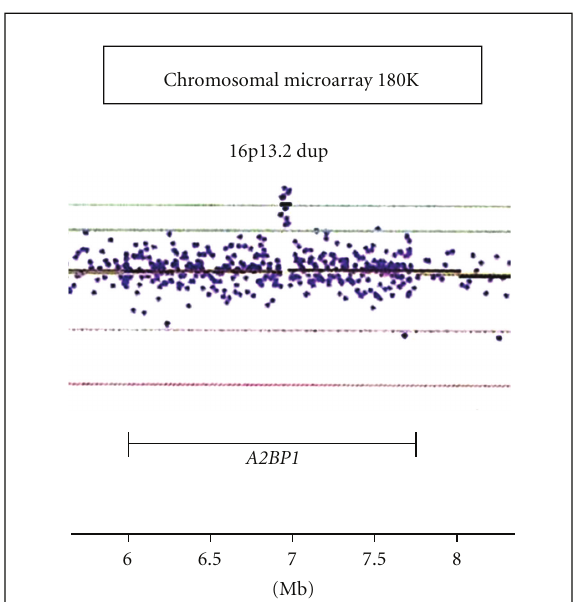
Figure 2: Chromosomal microarray analysis of the proband showed a 53kb duplication of the 16p13.2 region occurring at 6,936,805 to 6,990,017 bp from the p-terminus which includes a partial duplication of the A2BP1